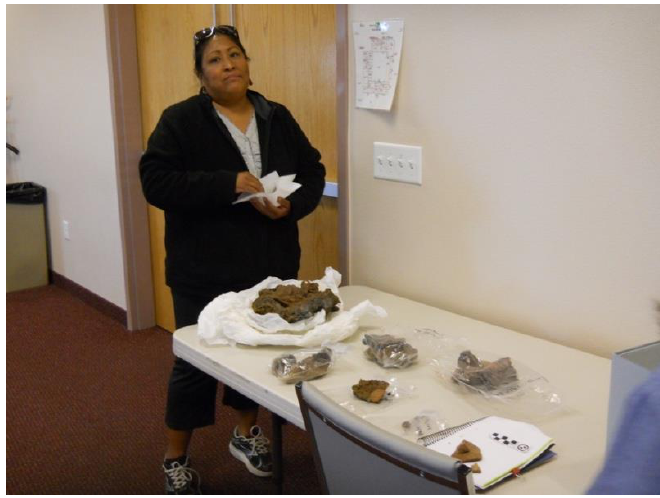
Figure 19. Southern Paiute Tribal Representative Examining the Sherd Rocks.